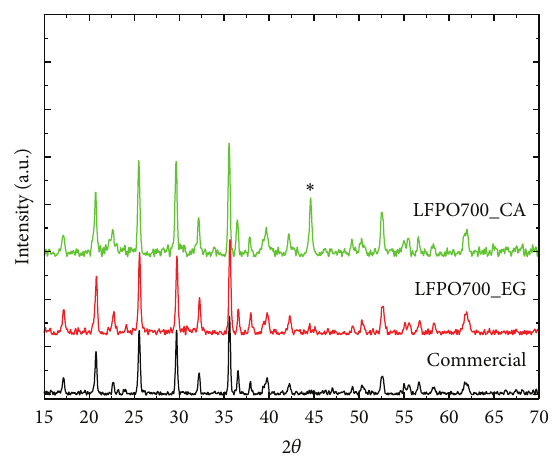
Figure 1: XRD profiles of the LiFePO 4 products fabricated using CA orEGchelatingagents(chelatingtoironprecursormolarratiois0.5) and sintered at 700 ∘ C. The diffraction peak labeled with ∗ indicates the metallic Fe impurity in the corresponding